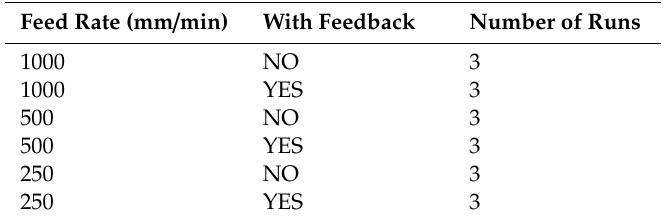
Table 1. List of all ballbar test runs.